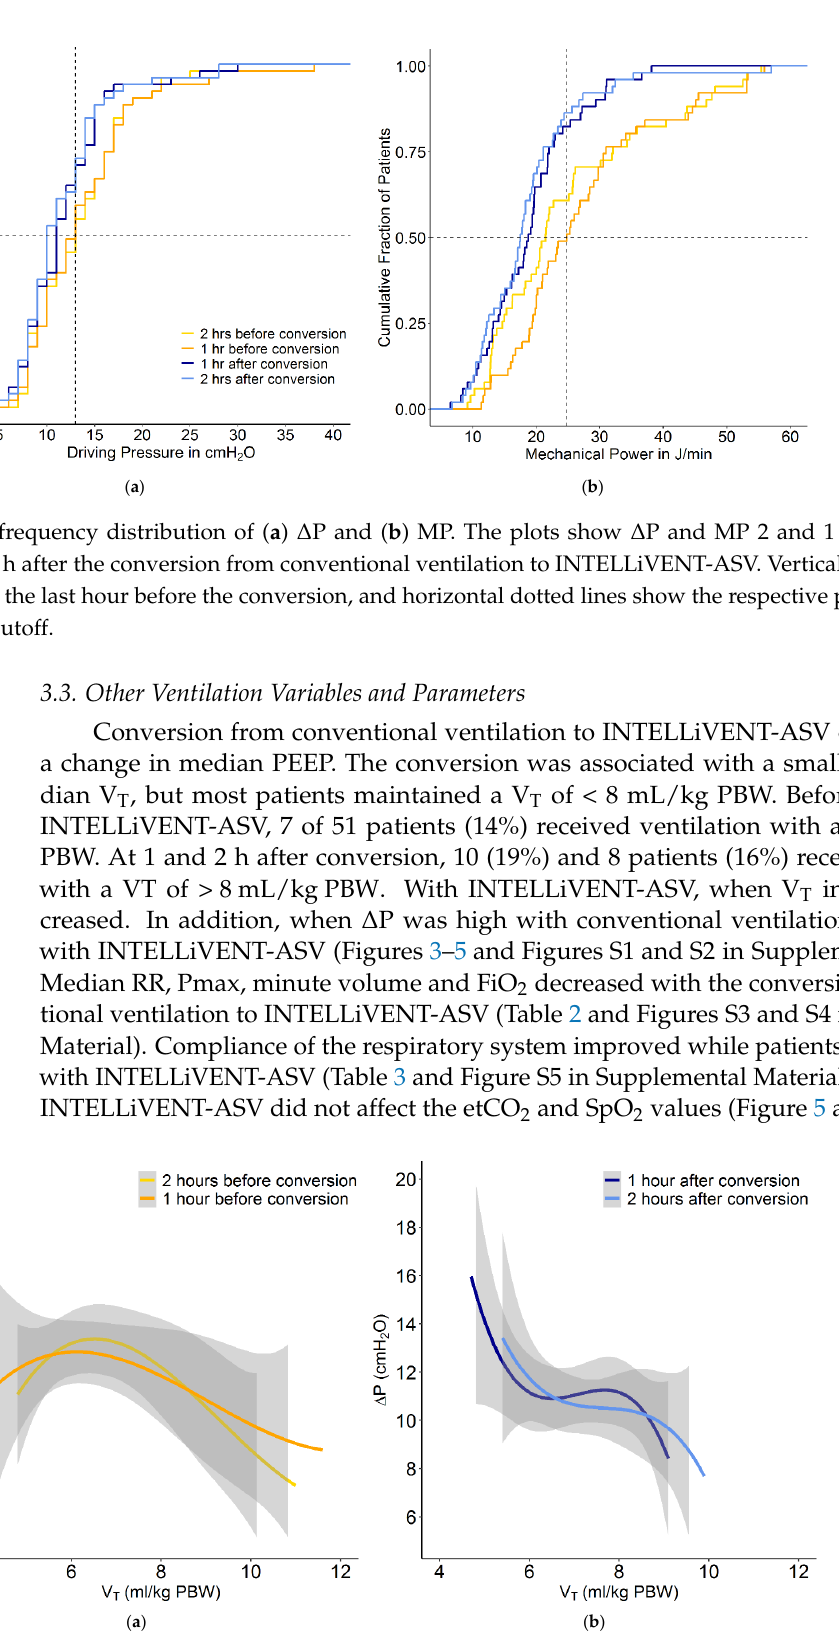
( b ) Figure 4. Scatterplot of individual changes in ( a ) tidal volume (ml/kg PBW) and ( b ) driving pressure (cm H 2 O) when the patients were switched from conventional ventilation, at 1 h before conversion, to INTELLiVENT-ASV (V T , INTELLiV- ENT-ASV-V T , INTELLiVENT-ASV; and Δ P, INTELLiVENT-ASV- Δ P, conventional) 2 h after conversion. Continuous line; regression lines. Each patient was characterized by a single data point. A negative value for V T or Δ P means that the conversion to INTELLiVENT-ASV resulted in a lower V T or Δ P, and a positive value means that V T or Δ P increased after the conversion.